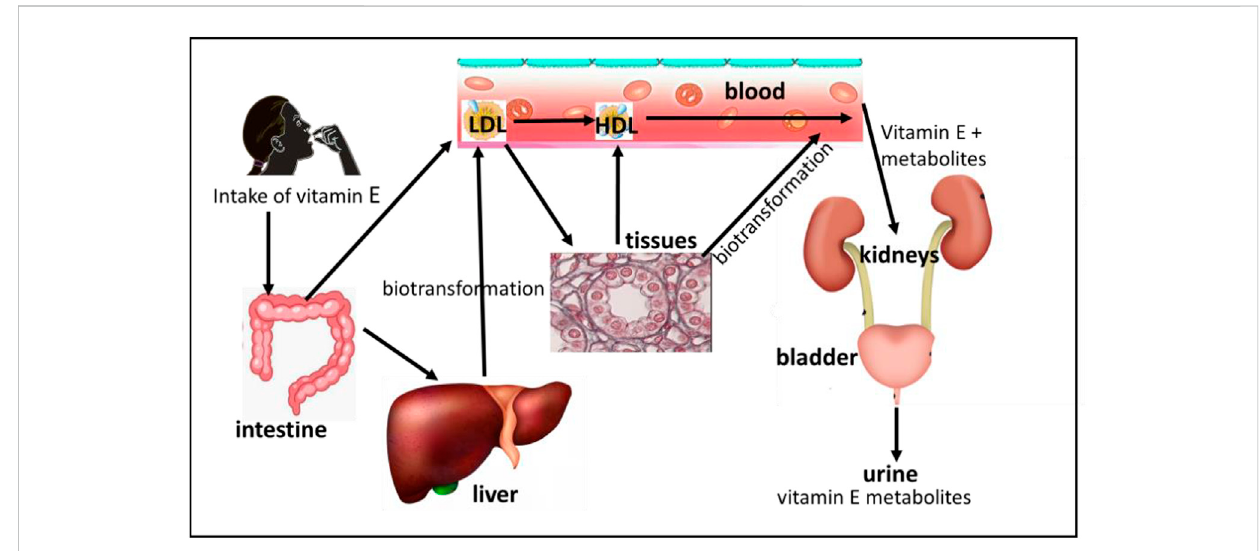
A schematic representation of the metabolic fate of vitamin